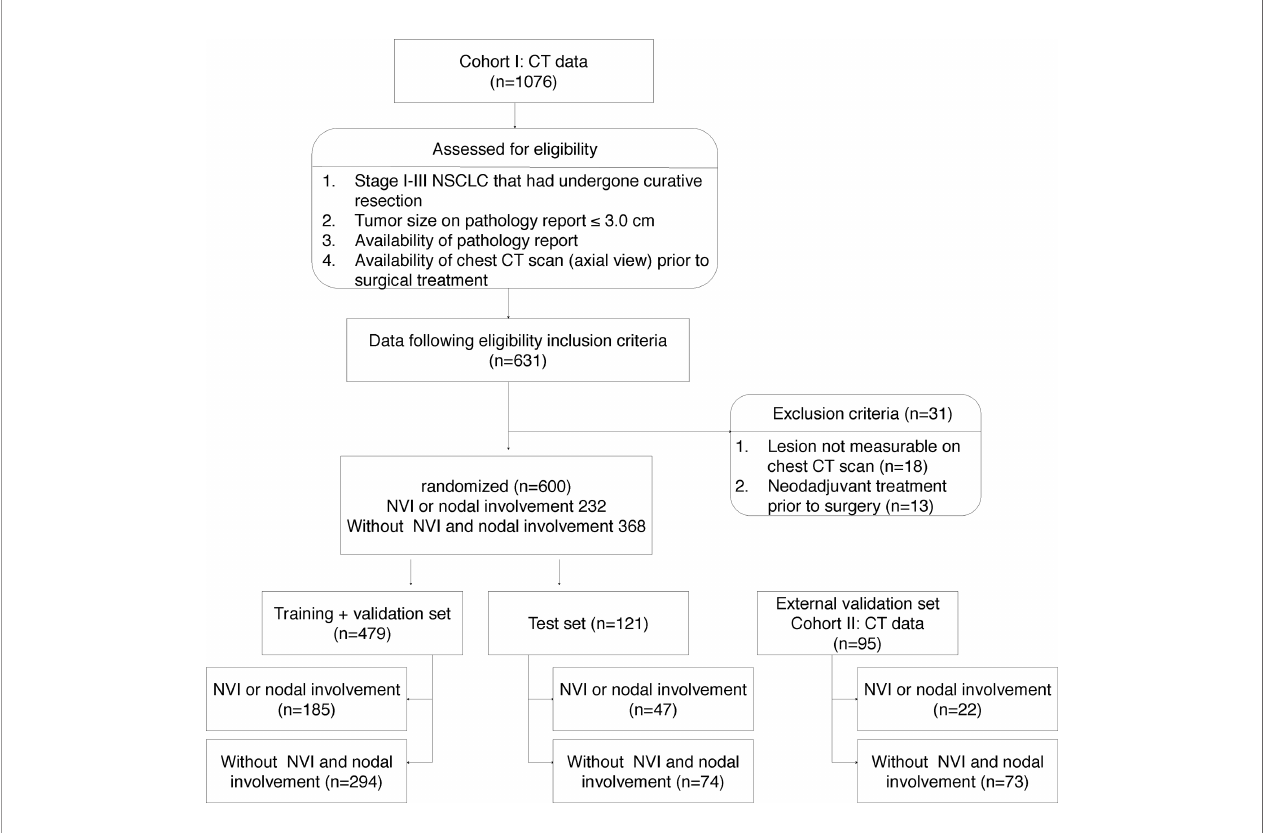
FIGURE 1 | Data criteria and speci fi cation.